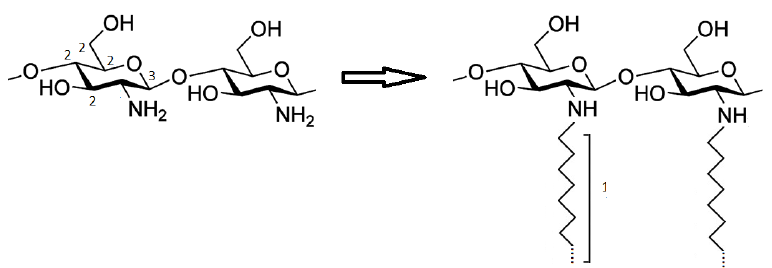
Figure 4. Chitosan chemical structure before and after the functionalization and assignment of the main component peaks in the C1s spectra.